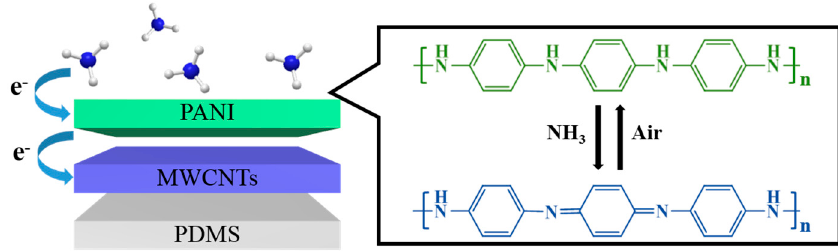
Figure 6. Gas sensing mechanism of PANI-MWCNTs/PDMS sensor.